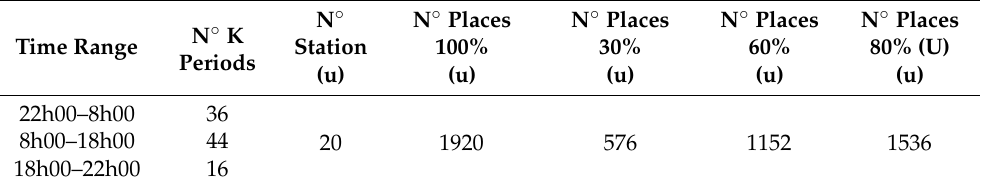
Table 3. Summary of the tests carried out with an hourly rate.